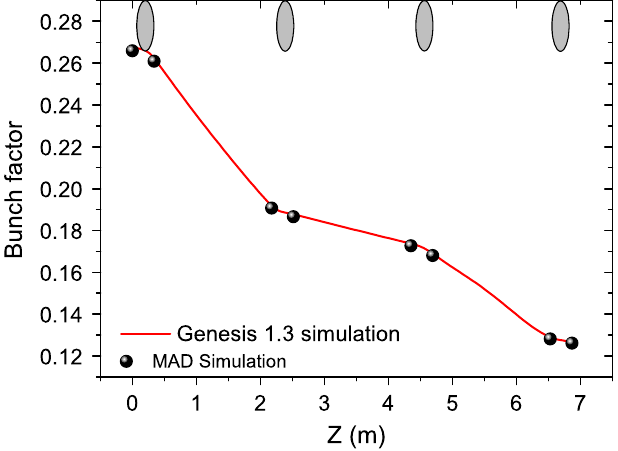
FIG. 2. (Color) Bunch factor development in matching section for (cid:4) and (cid:1) according to Eq. (5). The code GENESIS 1.3 (solid line) and MAD8 (circles) are used for this